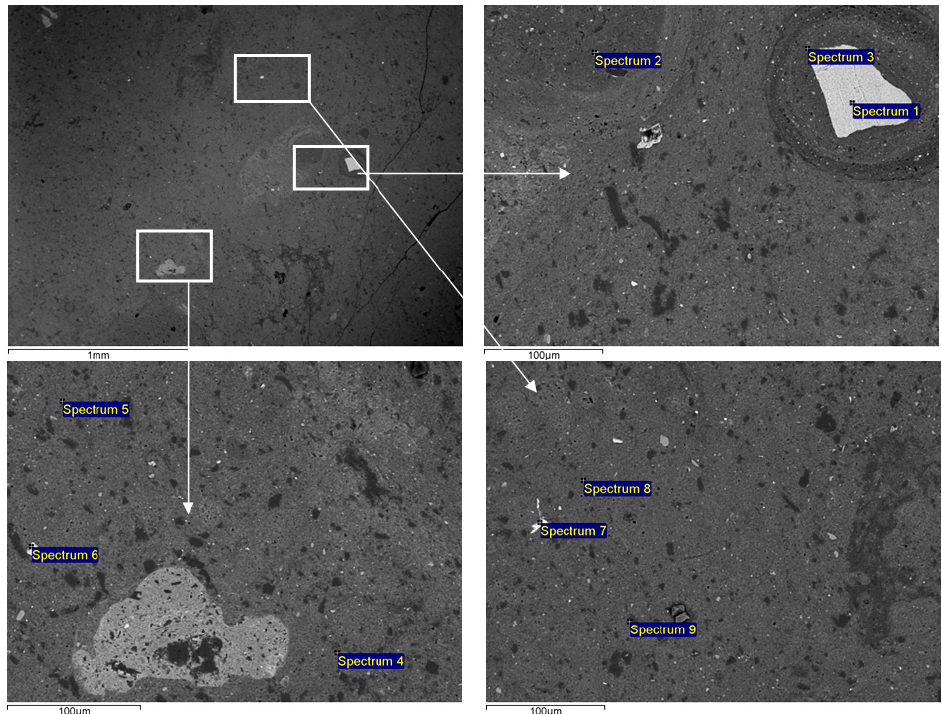
Figure 10. Bauxite deposit Borova brda. Analysed field 1—sample 180, with details and analysed points. Spectrum 1, 4, 6—Hematite; Spectrum 2, 5; Spectrum 3, 7, 8—Monazite; Al + Fe–hydroxides; REE—carbonate; Spectrum 7–8—Monazite; Spectrum 9—Clay + Fe–hydroxides.